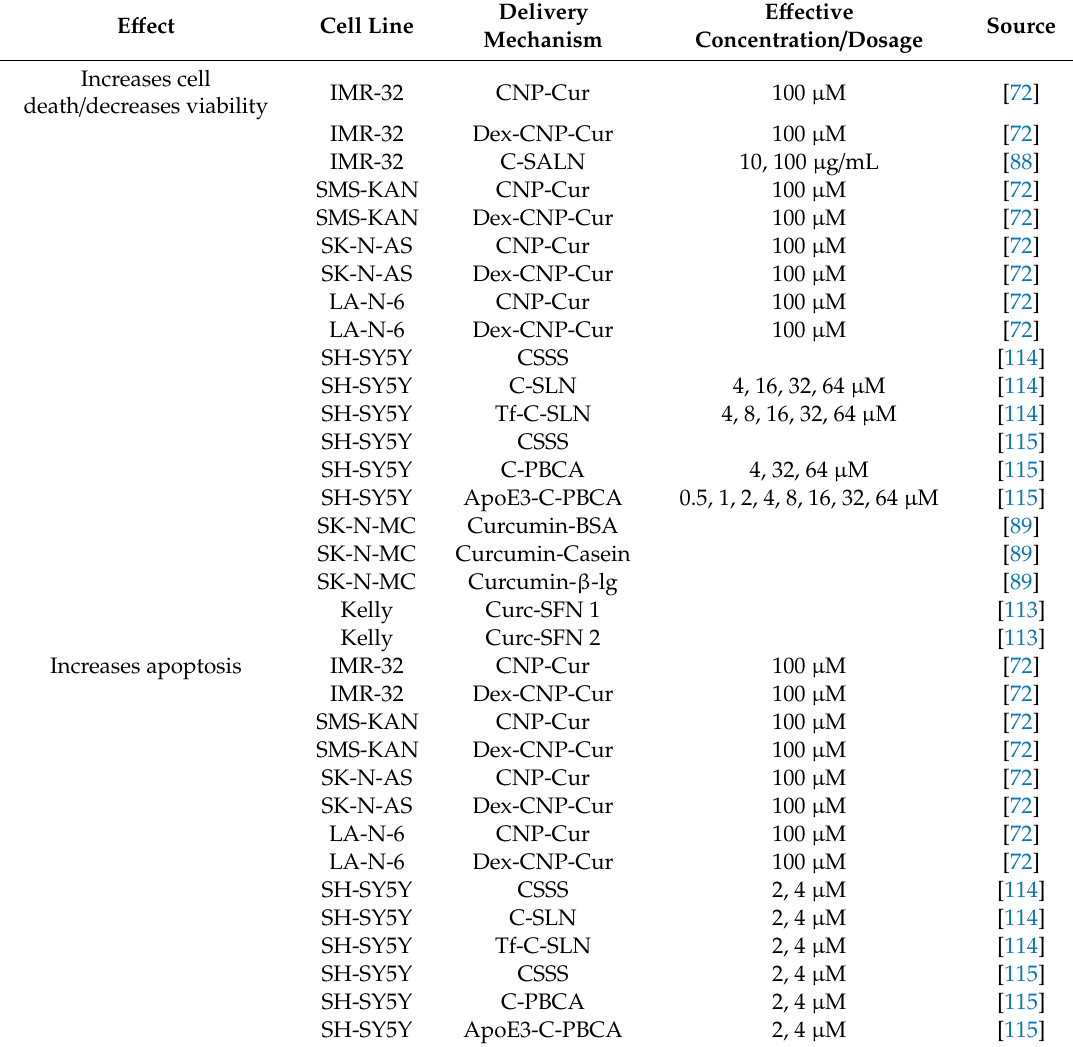
Table 5. Anticancer e ff ects of various curcumin formulations, including protein-conjugated nanoparticles and curcumin-protein complexes, on NB cell lines. While a variety of novel curcumin formulations successfully induce NB cell death, their specific mechanistic actions remain unclear. Downregulations, decreases, and inhibitions are in